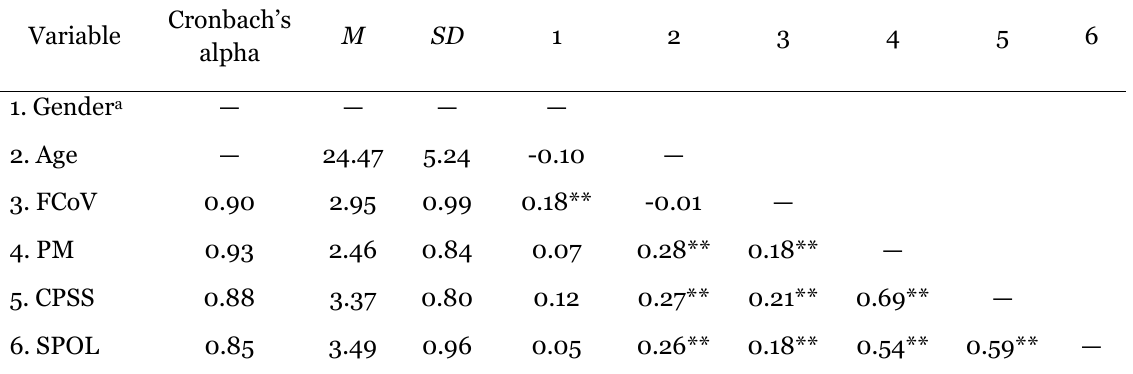
Cronbach’s Alpha, Means, Standard Deviations, and Correlations for the Study Variables Cronbach’s Variable alpha